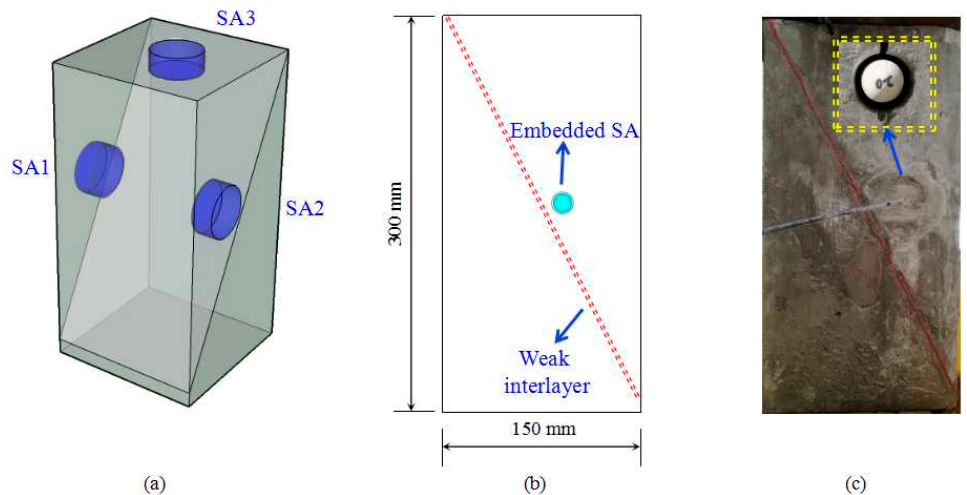
Figure 3. The schematic and photo of the specimen. ( a ) 3D sketch; ( b ) left lateral view; ( c ) photo.